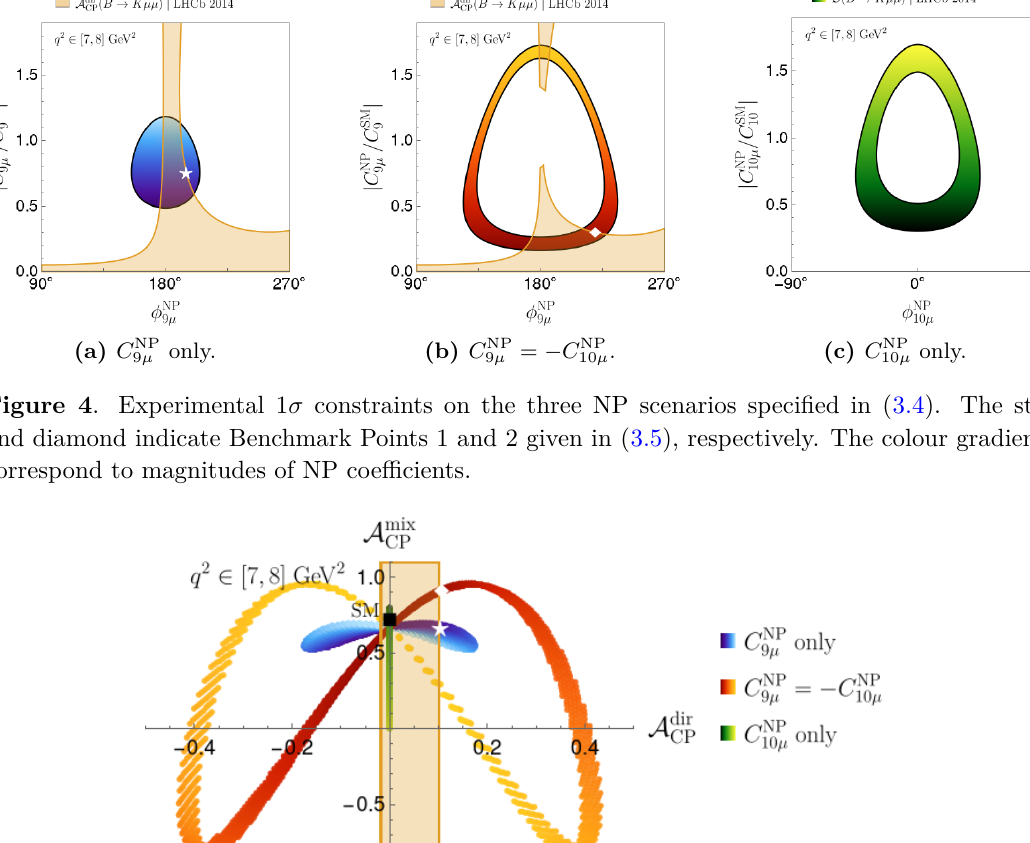
Figure 5 . Correlations between the CP asymmetries A dir in (3.4). The SM point is marked by a square, and the current experimental bound on the direct CP asymmetry is illustrated by an orange vertical band. The colour gradients match those of figure 4 and indicate magnitudes of NP coefficients. The lighter the colour, the larger the